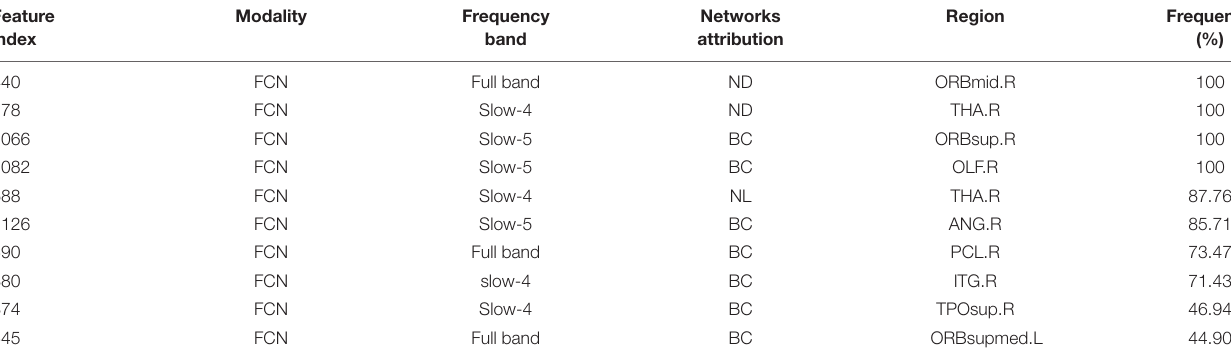
TABLE 7 | Selected feature distributions in the MCIc vs. AD group using the RSFS algorithm. Feature index